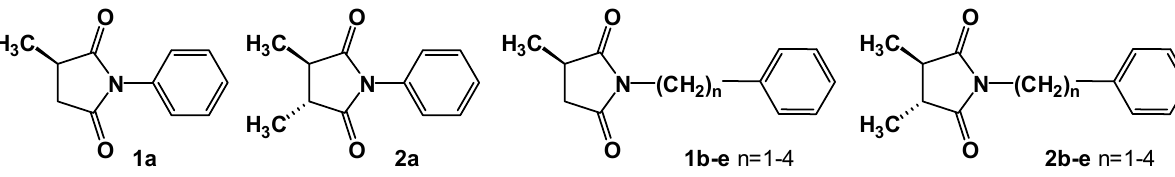
Figure 1. Structures of (3 R )-(+)-methyl- N- phenylsuccinimide 1a , (3 R ,4 R )-(+)-dimethyl- N- phenylsuccinimide 2a , (3 R )-(+)-methyl- N- phenylalkylsuccinimides 1b – e and (3 R ,4 R )-(+)- dimethyl- N- phenylalkylsuccinimides 2b – e [alkyl chain = (CH